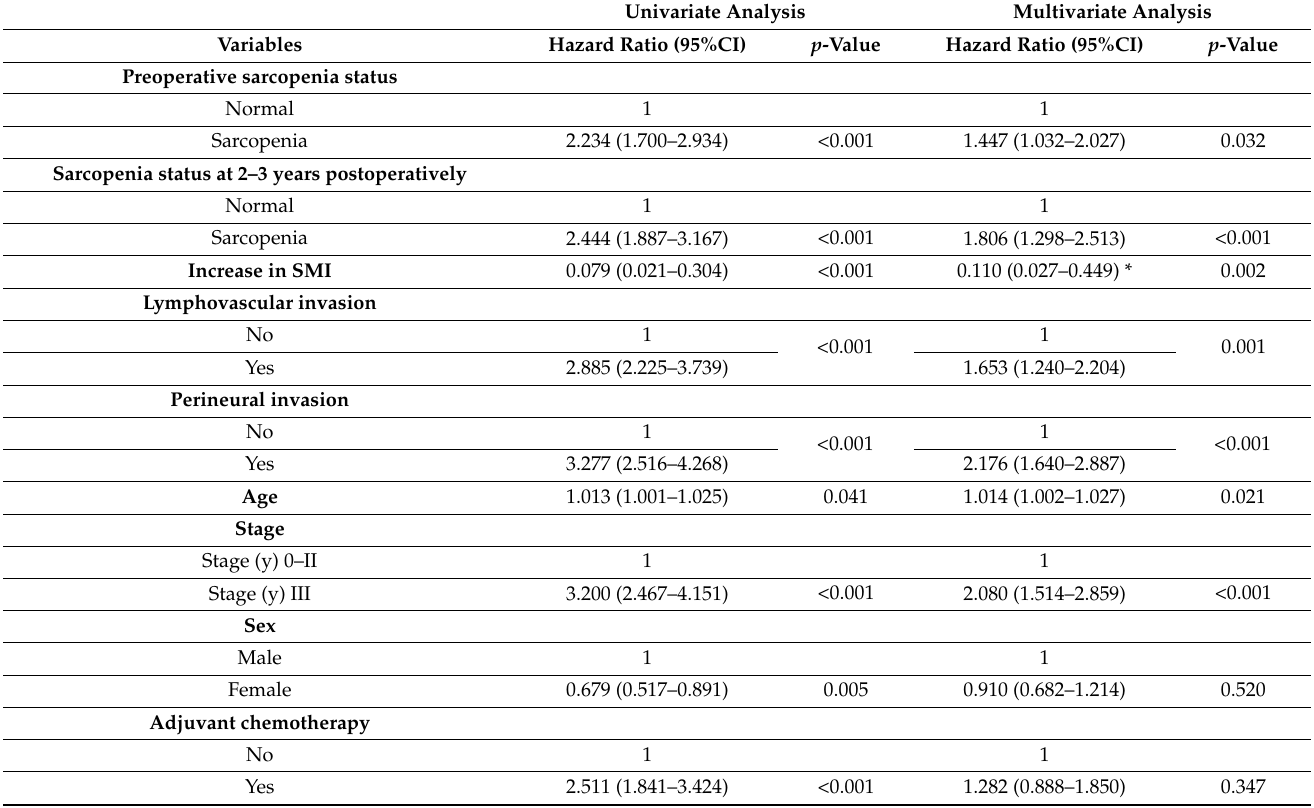
Table 3. Risk factors associated with overall survival (N = 2333, deaths =